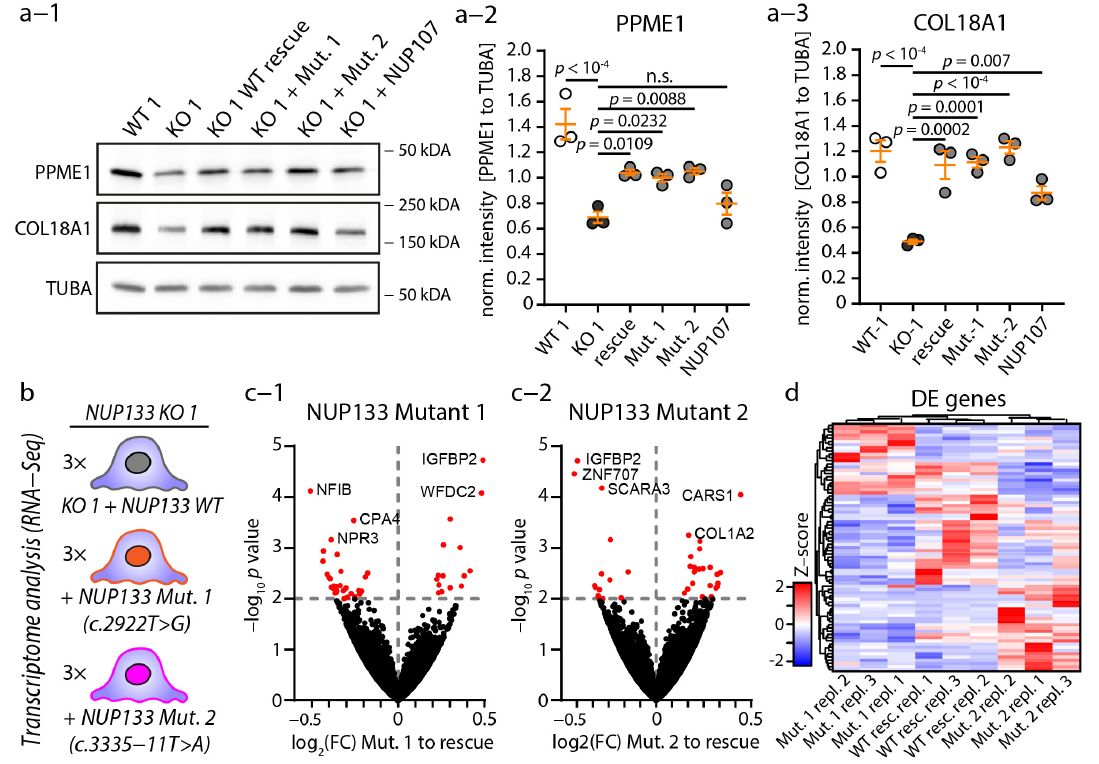
Figure 5. NUP133 variants do not significantly alter transcriptome composition. ( a-1 , a-2 , a-3 ) Western blot analysis of NUP133 KO, WT, and mutant cell lines for PPME1 and COL18A1. Alpha-tubulin (TUBA) was used as loading control and three independent replicates were analyzed (scatterplots; n. s.—non-significant). ( b ) Schematic of the experimental setup for transcriptome analysis of NUP133 KO-1 podocytes, expressing either WT or mutation carrying NUP133 cDNAs. Three replicates, per genotype and clone, were sequenced, and mutant variants were compared to NUP133 WT. ( c-1 , c-2 ) Volcano plot of differential expression analysis for NUP133 Mutant-1 or Mutant-2 versus NUP133 WT (rescue) podocytes. Red dots indicate 45 differential expressed gene transcripts for Mutant-1 ( c-1 ), with 37 for Mutant-2 (( c-2 ); p -value < 0.01). ( d ) Heat map showing Z-scores for these 77 by at least one mutant variant regulated transcripts, as well as unsupervised grouping of analyzed